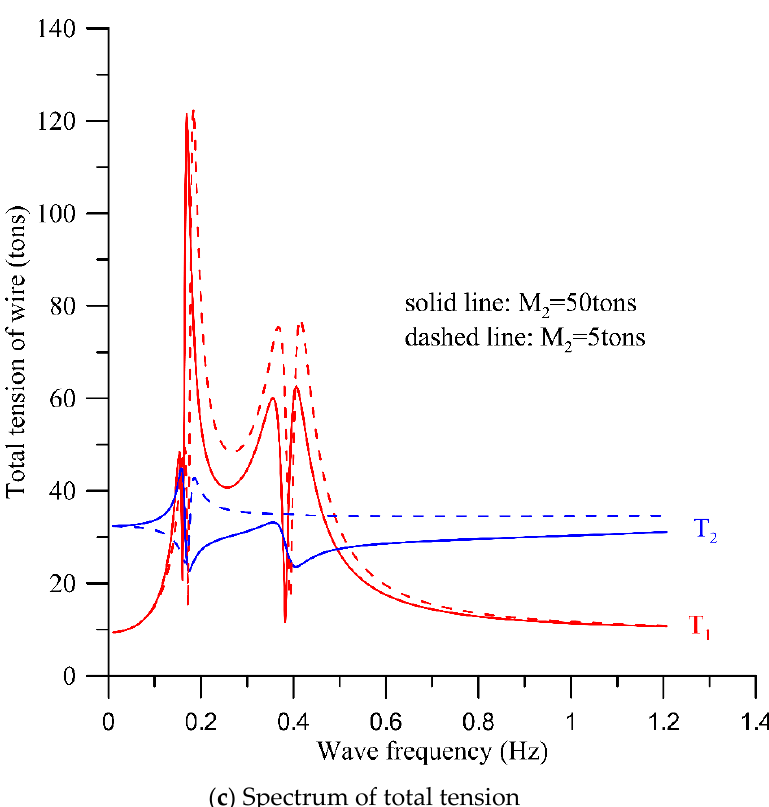
Figure 4. Effects of the mass of the pontoon, M 2 , and the wave frequency f on the dynamic re- sponse of the system including ( a ) dynamic displacements { x 1 d , x 2 d , y 1 d } , ( b ) dynamic tensions of rope { T 1 d , T 2 d } , ( c ) total tensions of rope { T 1 , T 2 } . [ A BB = 3 m 2 , A CYF = 15 m 2 , A CYP = 65 m 2 , C DYF = 0.3, C DYP = 1.28, E 1 = E 2 = 100 GPa, H bed = 1300 m, H 0 = 10 m, M 1 = 200 tons, m ef f , x = 8.151 tons, m ef f , y = 17.480 tons, L 1 = 2934 m, L 2 = 60 m, V = 1 m/s, θ 1 = 25 ◦